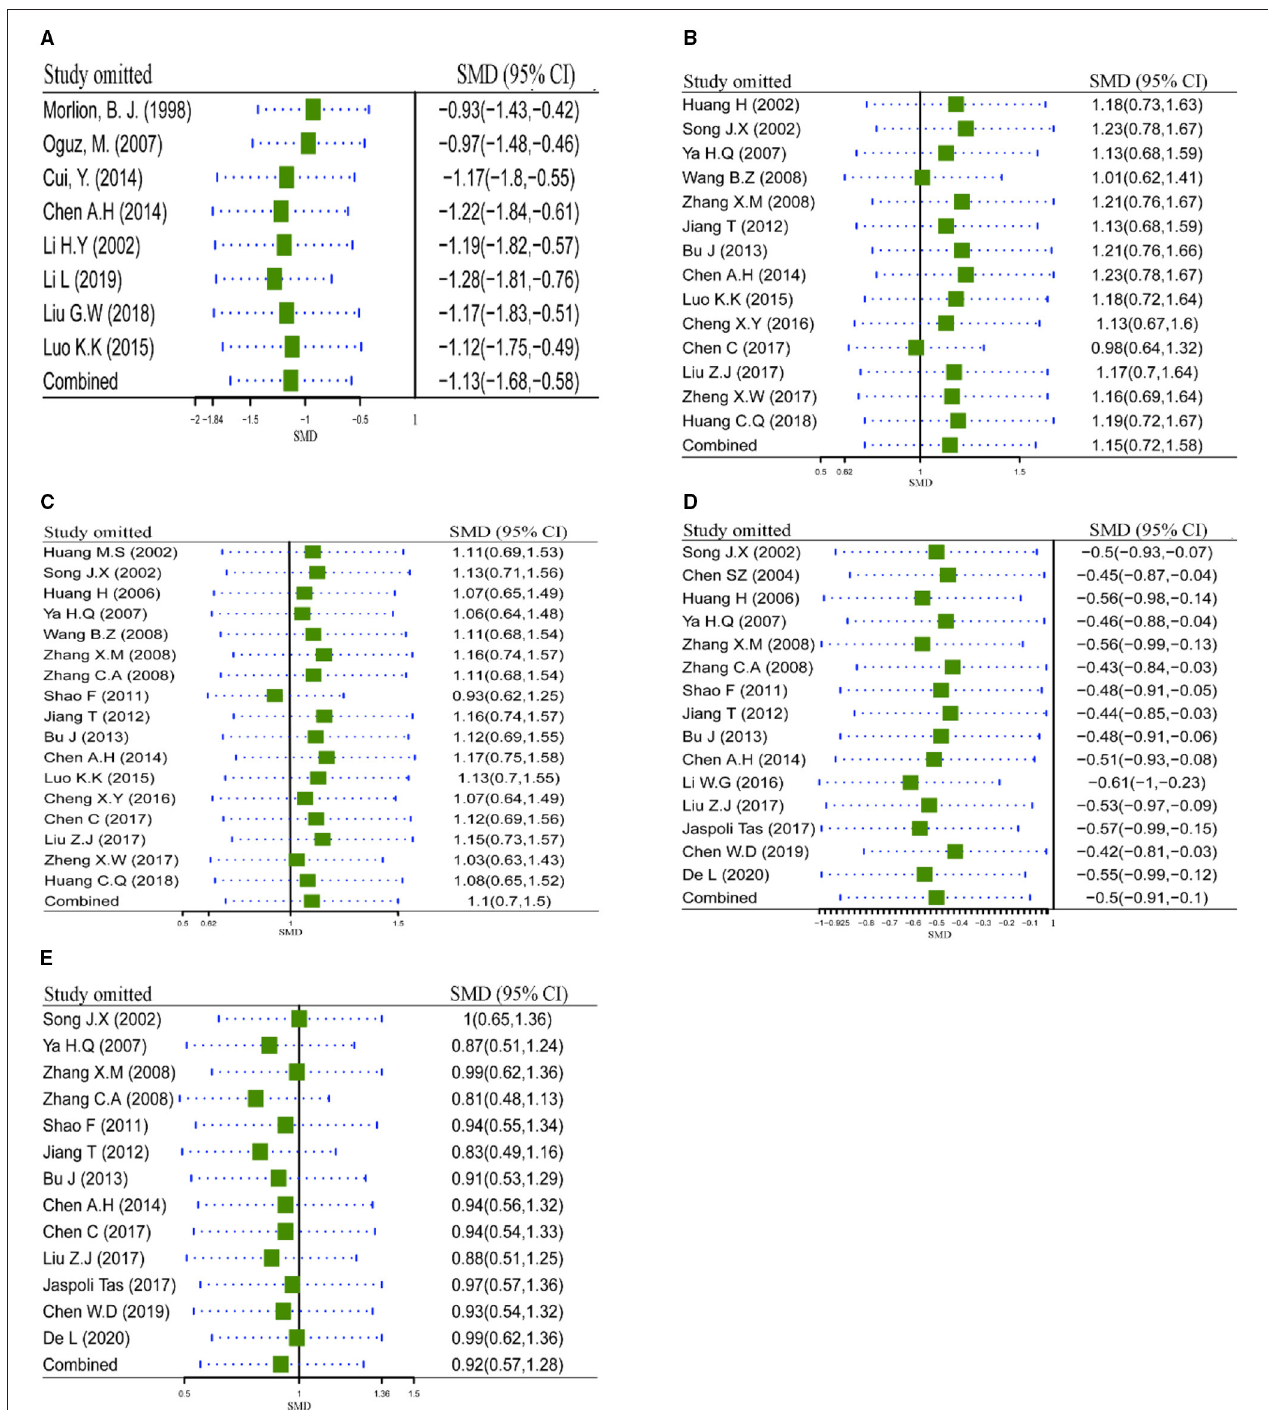
FIGURE 6 | Sensitivity analysis via leave-one-out procedure each time. (A) Sensitivity analysis of LOS; (B) Sensitivity analysis of IgA; (C) Sensitivity analysis of IgG; (D) Sensitivity analysis of CD8 + ; (E) Sensitivity analysis of CD4 + /CD8 + . LOS, length of hospital stay.